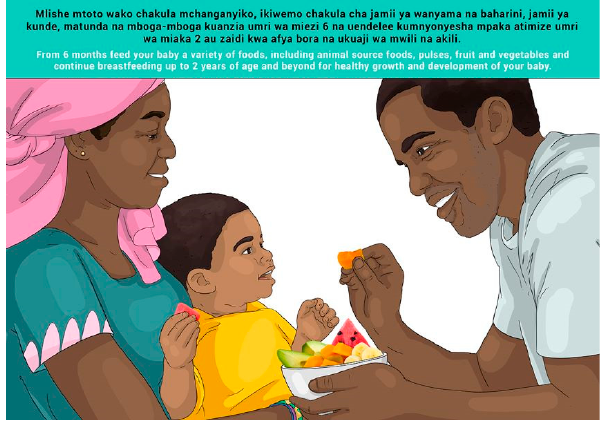
Figure 12. From 6 months feed your baby a variety of foods, including animal source foods, pulses, fruit and vegetables and continue breastfeeding up to 2 years of age and beyond for healthy growth and development of your baby.